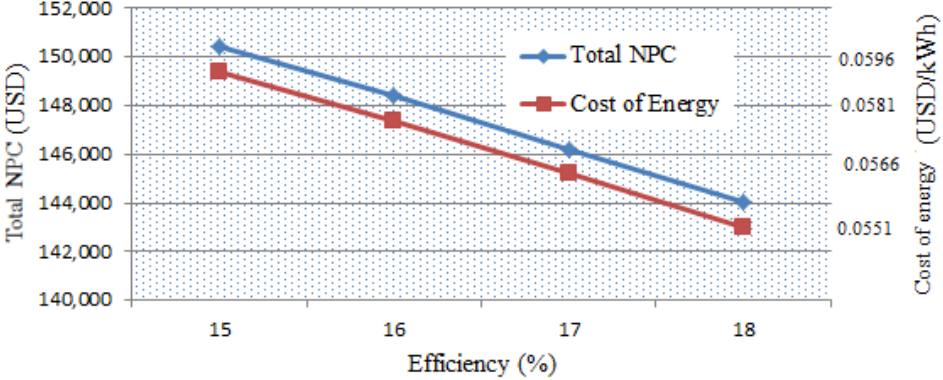
Figure 15. Impact of PV panel efficiency variation on the NPC and COE. Impact of Solar Irradiation Change Figure 16 indicates the outputs of the sensitivity analysis of the optimal grid/PV sys- tem regarding a change in solar irradiance from 5.1 kWh/m 2 /day to 6.6 kWh/m 2 /day. The load (324 kWh/day) and the grid COE (0.04 USD/kWh and 0.07 USD/kWh) of the location were fixed simultaneously. It could be expected that the rise in solar radiation would cause an increment in PV output and consequently increase the renewable fraction and decrease the NPC of the system, as shown in Figure below. From the figure, we can ob- serve that when the solar radiation increases by 23%, the NPC decreases by 12.5%. With the same radiation percentage increment, the COE decreased by 13%. Figure 16. Impact of solar irradiance change on the NPC and RF. 5. Conclusions Currently, Ethiopia has given more consideration to increasing the share of its energy supply from solar energy resources. In this respect, the government aims to encourage industries and commercial centers to produce their own energy by relying on renewable distributed energy sources. In this research, modeling, analysis and optimization of grid- integrated and islanded schemes of solar PV power systems considering future utility electricity tariffs for the residential load in the west of Mekelle City in Ethiopia were